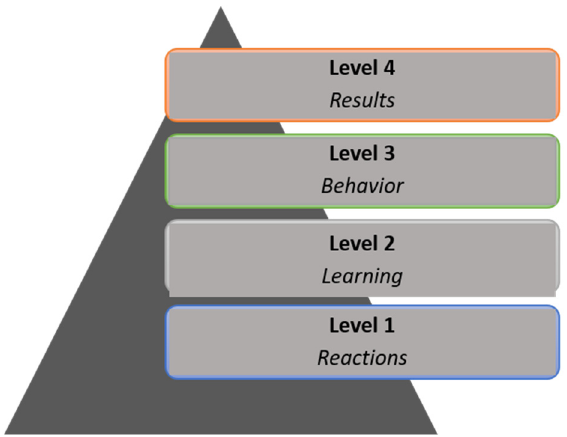
Figure 1. Kirkpatrick